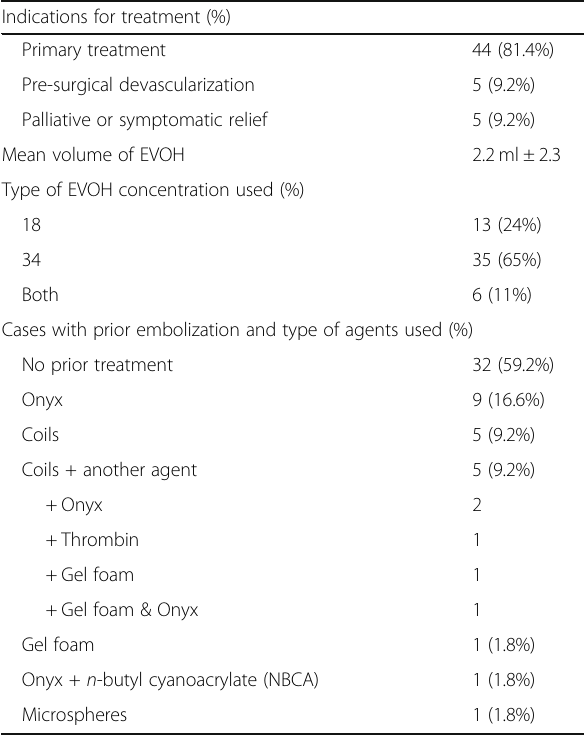
Table 2 Features of cases treated with EVOH ( n =